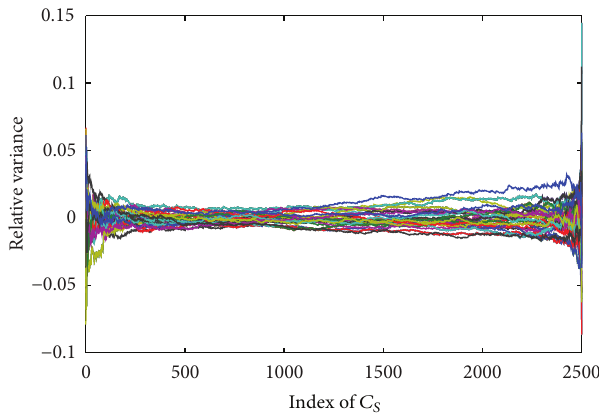
Figure 4: Relative deviations of subgraph centralities 𝐶 𝑆 (𝑖) of the WS small-world network model.